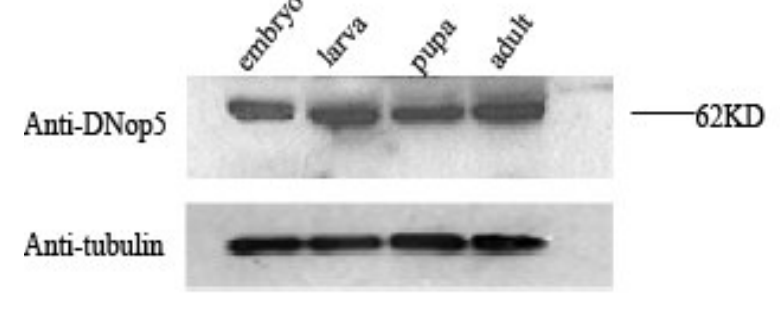
Figure 1. DNop5 is ubiquitously expressed throughout Drosophila development by western